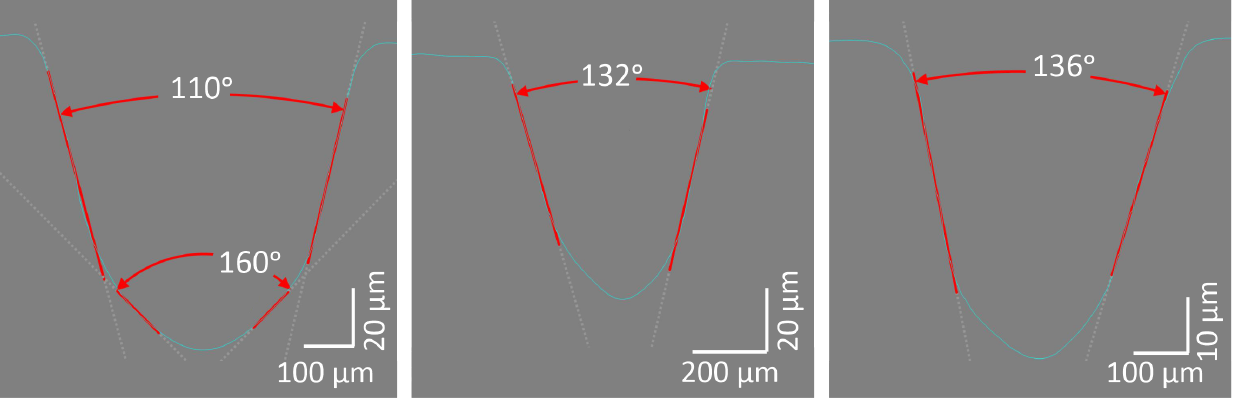
Figure 9. Grooves made with same fluence, F = 127 mm. ( left ): P = 30 W, S = 140 mm/s; ( center ): P = 60 W, S = 280 mm/s; ( right ): P = 90 W, S = 520